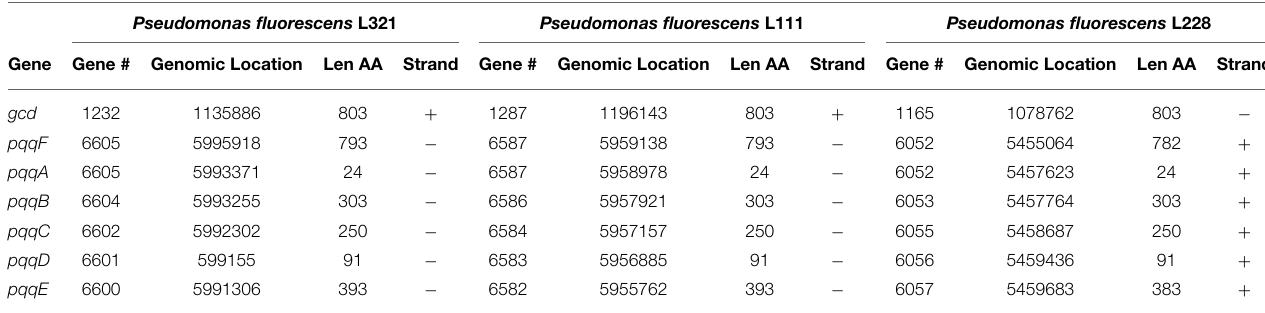
TABLE 3 | Genes implicated in the phosphate solubilization abilities of Pseudomonas fluorescens strains L228, L321, and L111. Pseudomonas fluorescens